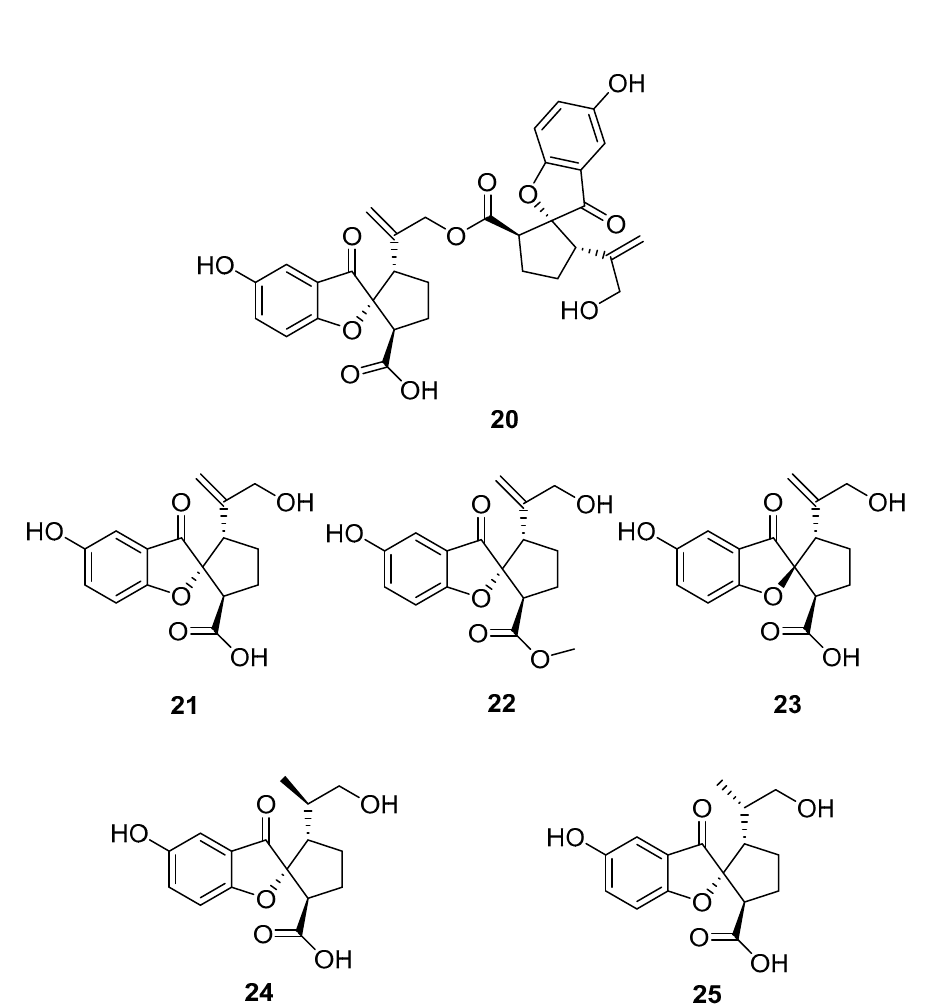
Figure 5. The meroterpenoids from Ganoderma leucocontextum.